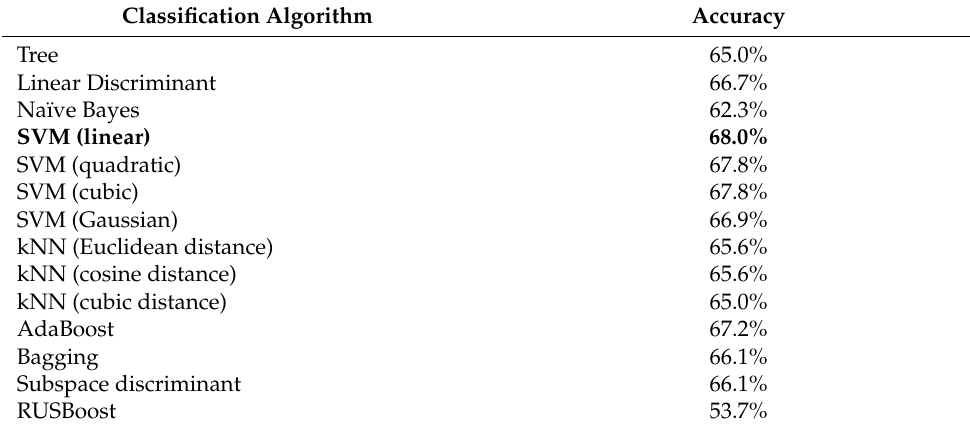
Table 2. Results of the accuracy performance assessment of various classification algorithms with the 369 occurrences after discarding features 7 (evolving fault) and 12 (mean 30-day ambient temperature).